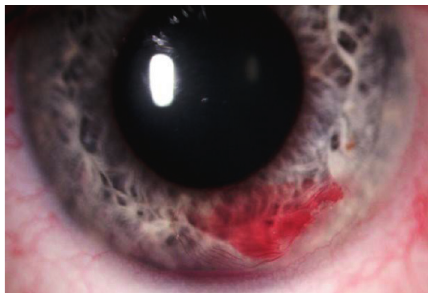
Figure 2: Complications of XEN implantation—bleeding into the anterior chamber.